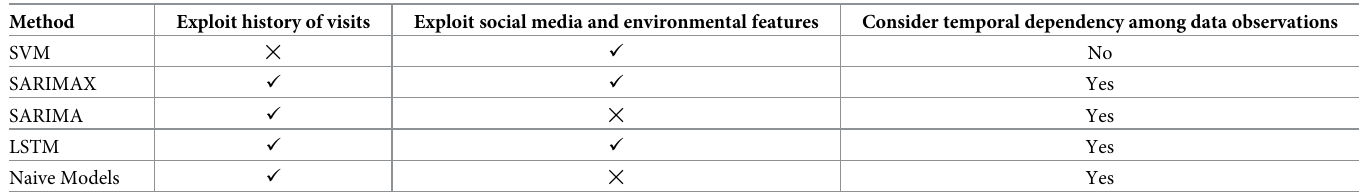
Table 3. Prediction techniques